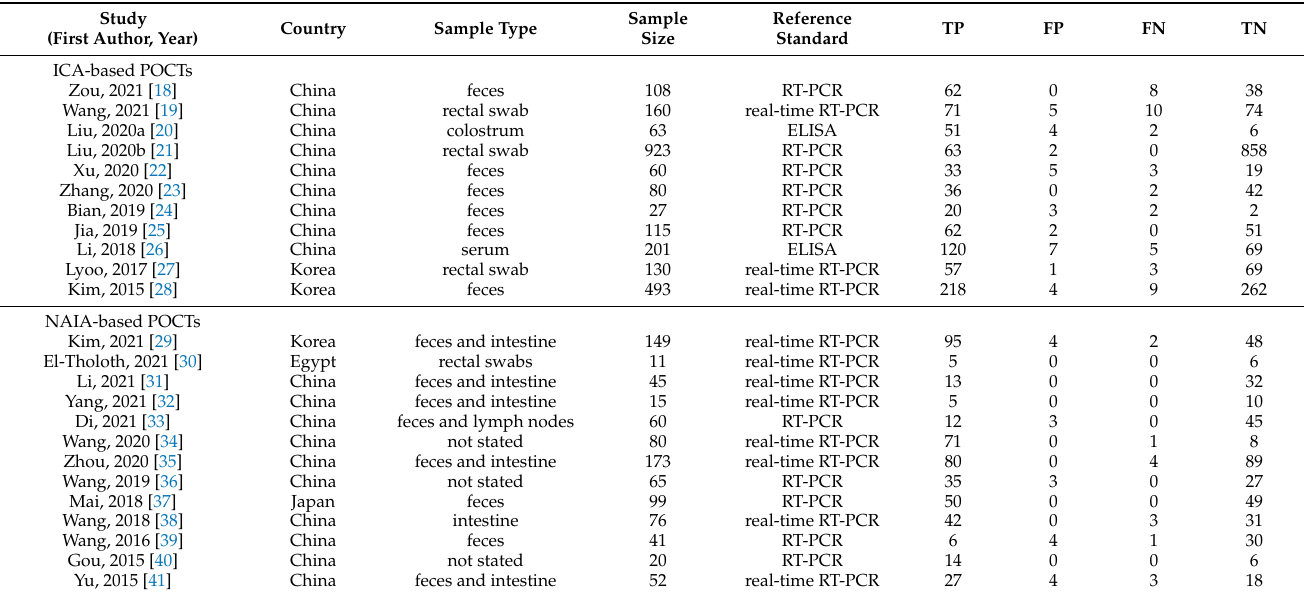
Figure 2. Risk of bias and applicability concerns graph: review of authors’ judgements about each domain presented as percentages across included studies. Numbers in the bars indicate the number of studies.